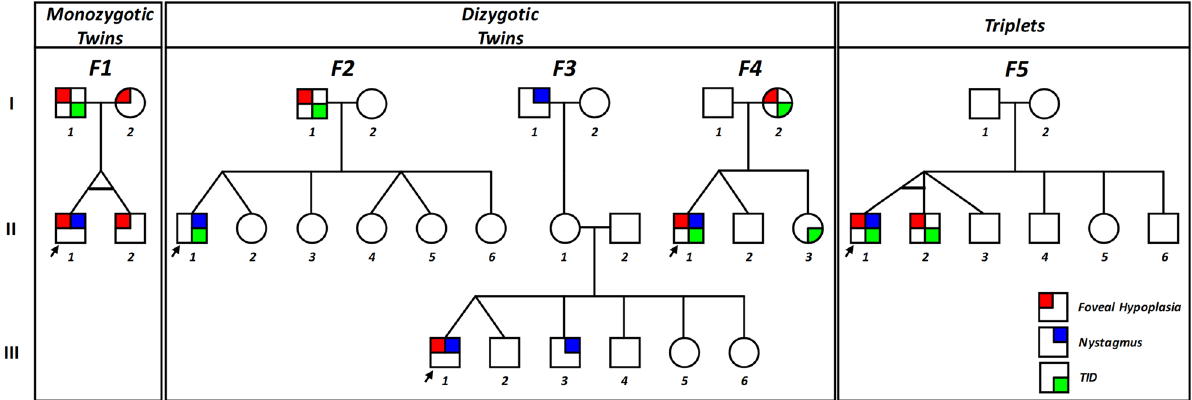
Figure 1. Pedigrees. Pedigrees of monozygotic twins (F1), dizygotic twins (F2, F3 and F4) and triplets (F5). The key for phenotypical characteristics shown. Arrow indicates proband. TID transillumination defects of the